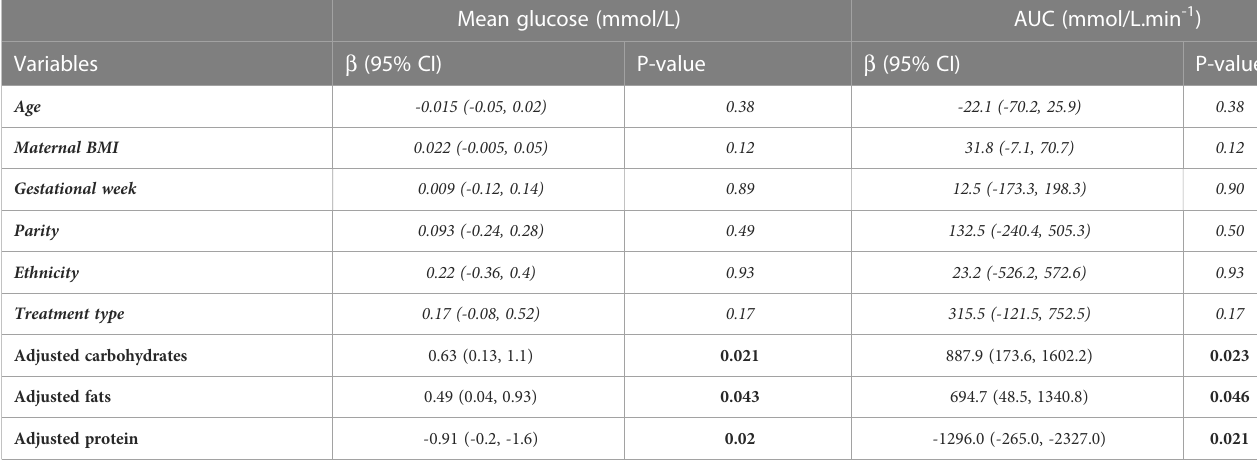
TABLE 4 Multivariable regression of dietary mediators (carbohydrates, fats, and protein) and glycemia strati fi ed by outcome metric of 33 participants that maintained dietary records and had CGM metrics